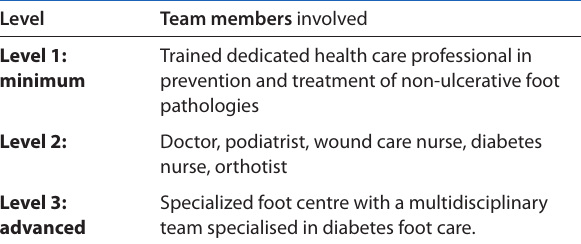
Table 12: Proposed levels of care adapted from Bakker et al 2012 1